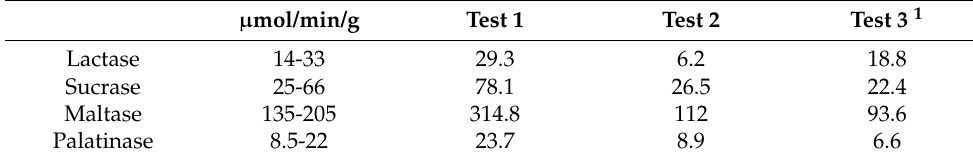
Table 2. Mucosal disaccharide